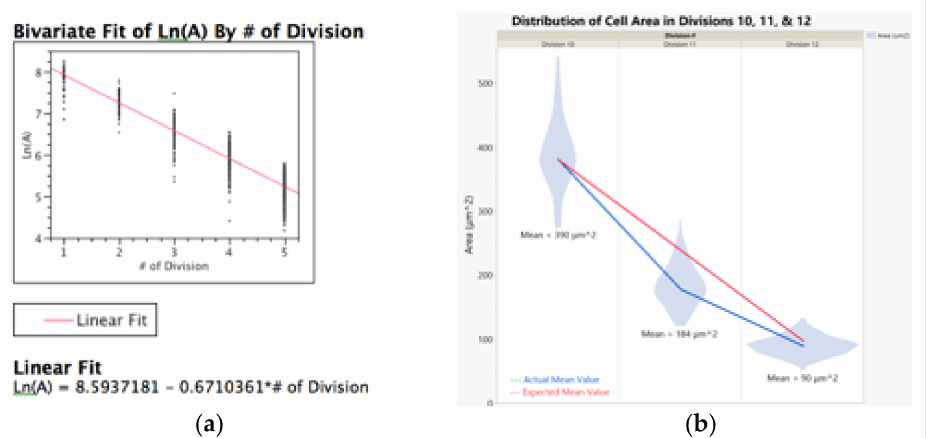
Figure 15. Tests of Errera’s rule that successive cell divisions have one-half the mean areas of the previous generation for tissues with simultaneous divisions of all cells. The linear regression of the ln(A) is plotted for five successive divisions. ( a ) Fruit flies ( Drosophilia melanogaster ) (data from [33]); test of Errera’s 1 rule: R-squared = 0.87, p < 0.0001. ( b ) Flour beetles ( Tribolium castenenum ) (data 2 from [31]]; violin plots of the areas of Voronoi cells in each of three successive divisions; the blue line connects the mean areas of each of the three generations; the red line is what would be expected if Errera’s rule was used to predict the means of successive